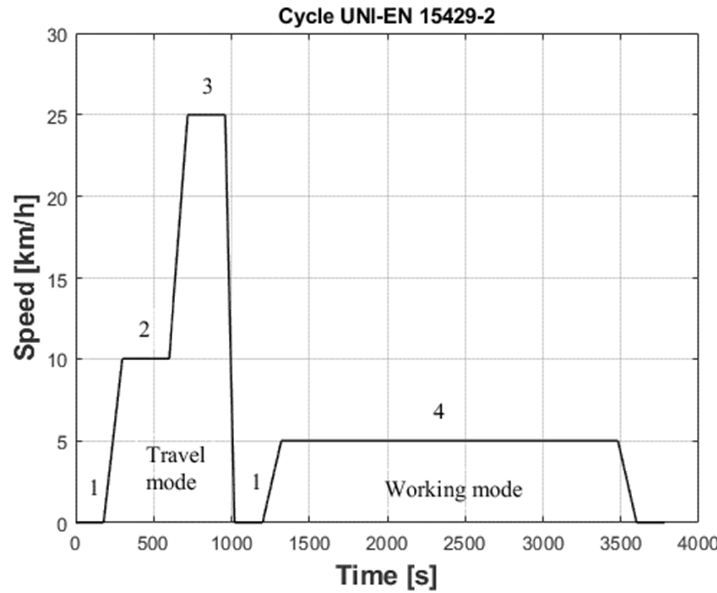
Figure 13. Cycle UNI-EN 15429. 1: idle speed, 2: FMP speed, 3: maximum speed, 4: working-mode speed.